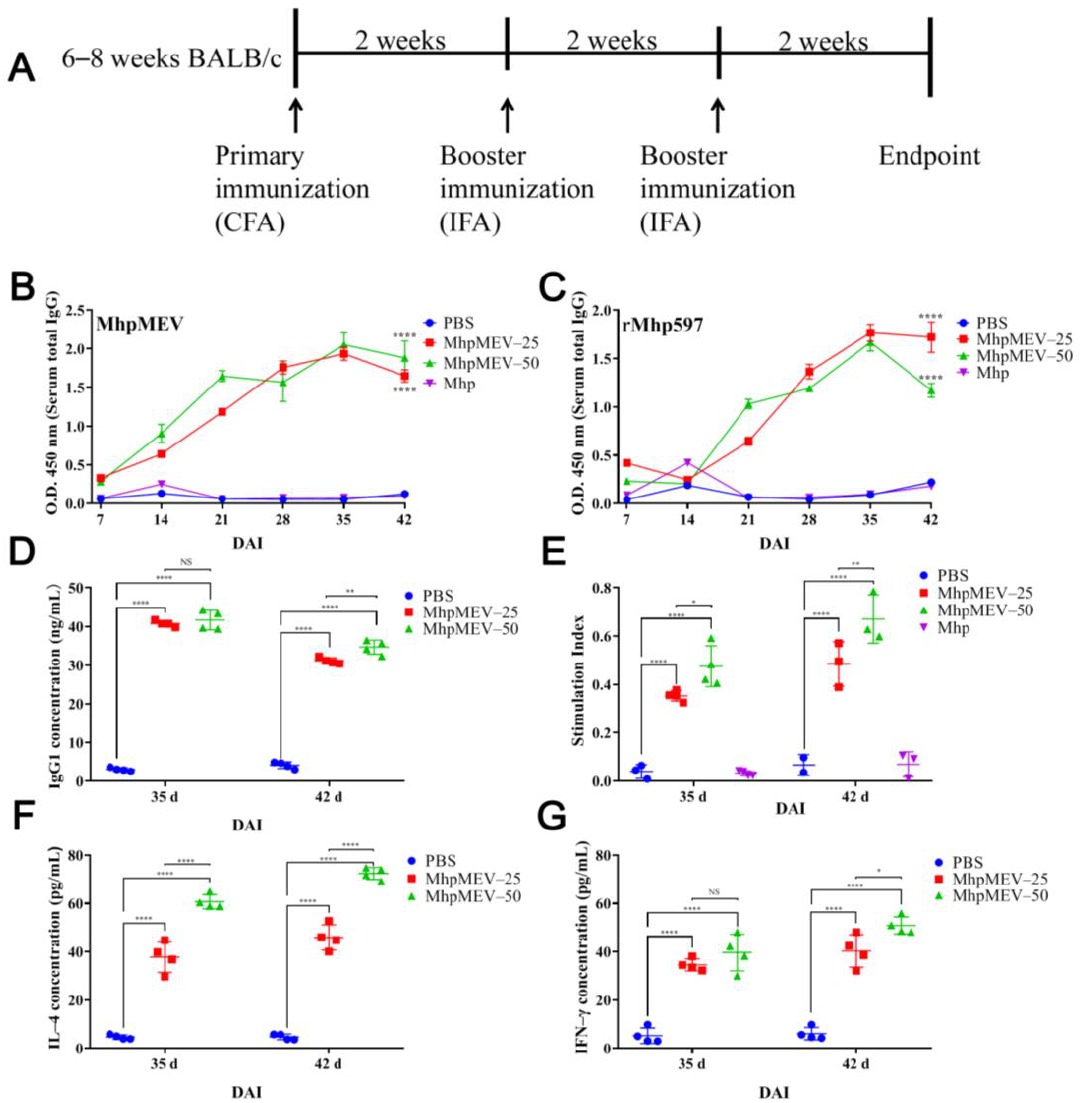
Figure 6. Immunoassay results of mouse immune experiment. ( A ) The vaccination schedule of the mouse immune experiment. CFA: complete Freund’s adjuvant, IFA: incomplete Freund’s adjuvant.